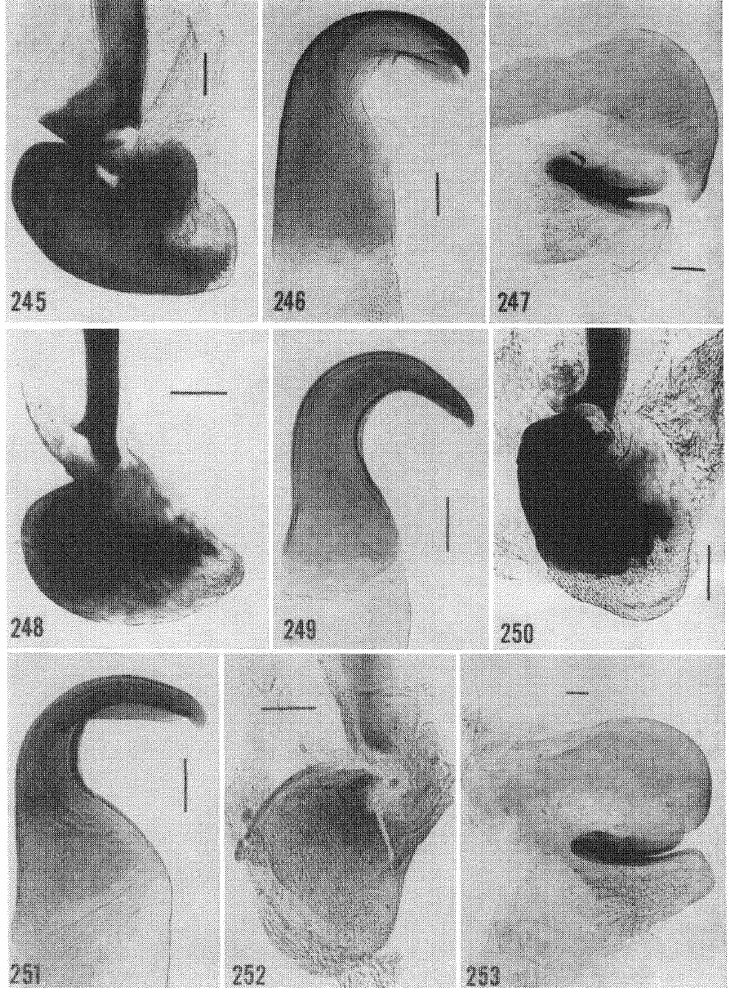
Figures 245-253. Male genital phallomeres of Perisphaerus spp. 245- 247. (983 L). P. aterrimus (from shown in Fig. 229). 248-251. P. arma- dillo. 248-249. (109 MCZ). (from shown in Fig. 234). 250-251. (982 L). (from shown in Fig. 233). 252-253. (180 ANSP). P. aeneus (Brunner). Sibuyan Island (det. Hebar,d). (scale 0.1